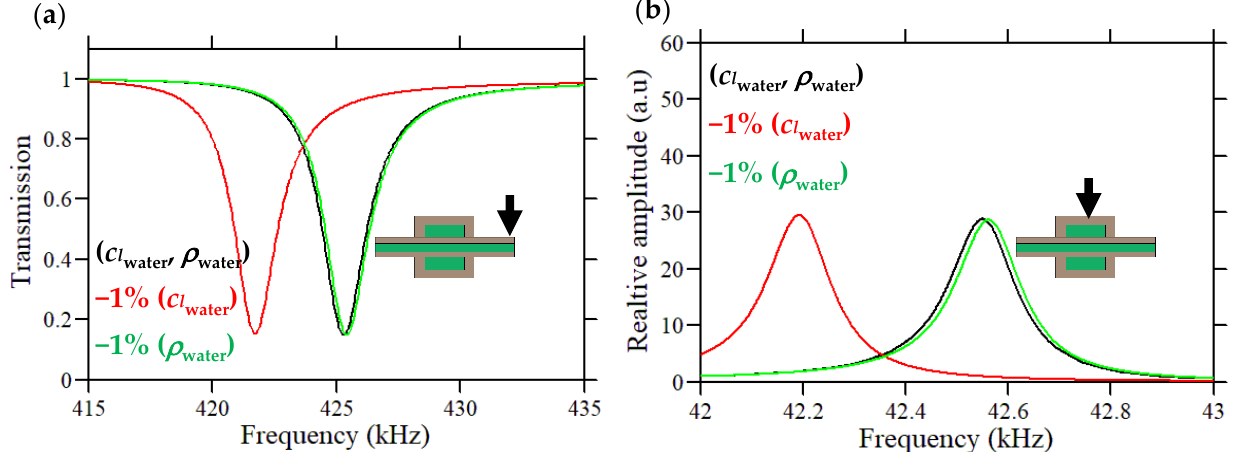
Table 1. Quality factor, sensitivity, and figure of merit of the sensor, including or excluding the viscosity.